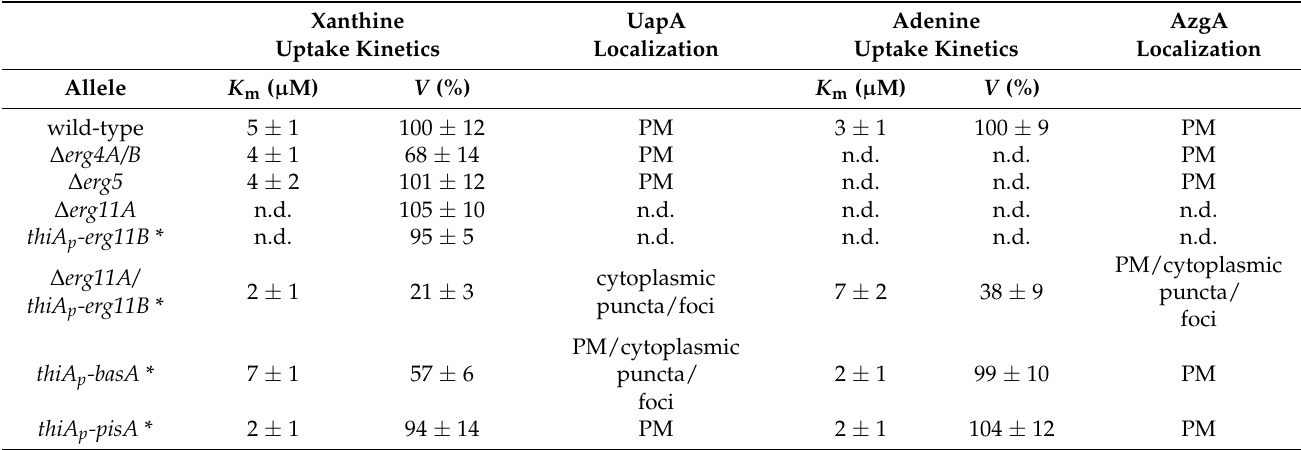
Table 1. Transport kinetics of UapA and AzgA in lipid biosynthesis mutants. Results shown represent averages of two independent experiments, using measurement from triplicates samples. UapA and AzgA subcellular localization, determined by epifluorescence microscopy in strains expressing GFP-tagged UapA or AzgA grown under the same conditions of transport assays, are also